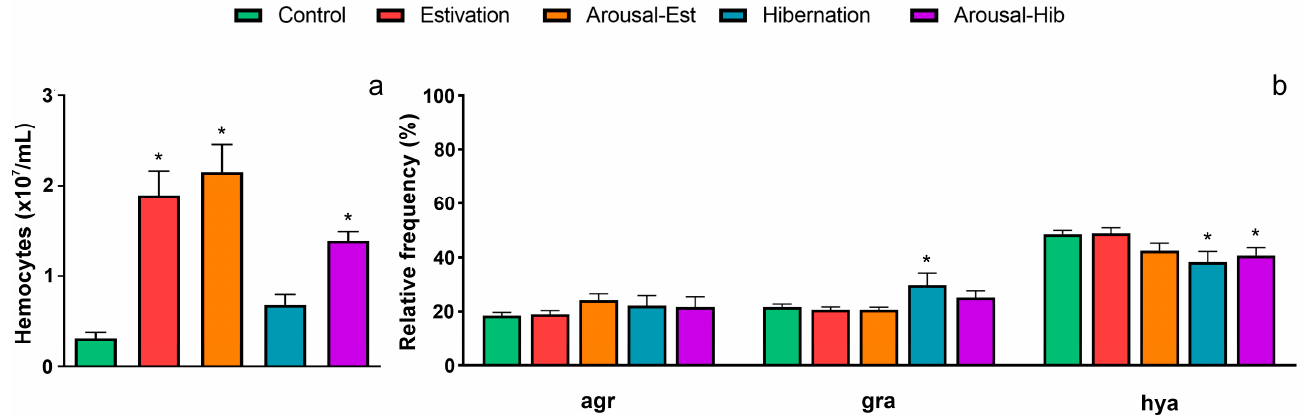
Figure 2. Changes in the circulating hemocytes of challenged animals. ( a ) Total hemocyte levels; ( b ) relative composition of circulating hemocytes. Asterisks (*) indicate significant differences with the control group ( p < 0.05, Kruskal-Wallis, Dunn’s test).